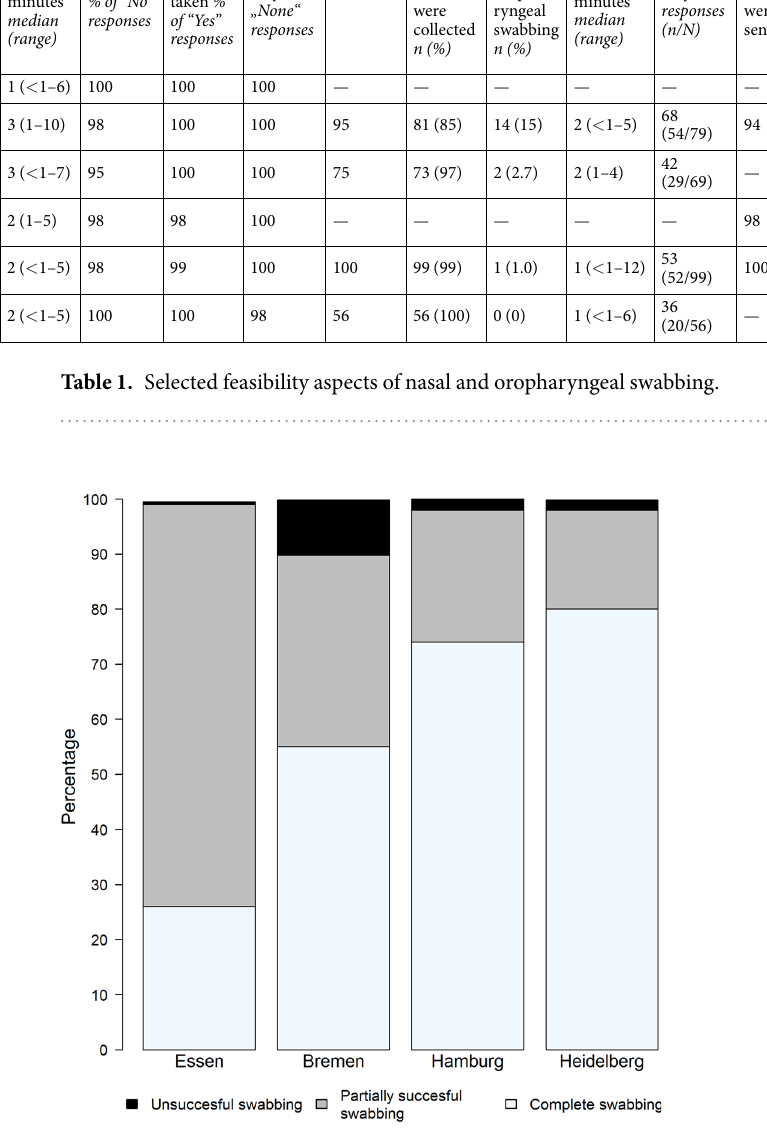
Figure 2. Completeness of oropharyngeal swabbing. The fraction of the anatomical structures swabbed successfully was recorded by the certified study personnel in the biosample protocol. Complete swabbing – all target structures (tonsils and pharyngopalatine arches bilaterally) could be swabbed; partially successful swabbing – the swab touched the mucous membrane of the pharynx in only one spot or only swabbed some areas of the pharynx; unsuccessful swabbing - the swab did not touch the oropharyngeal mucous membrane; i.e., the swab could not be